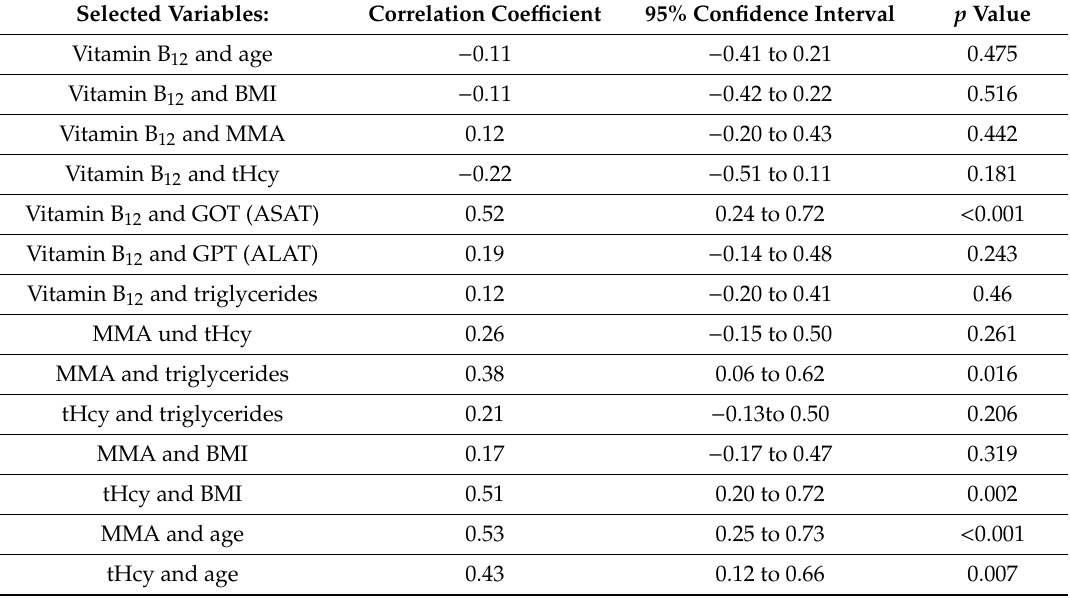
Table 3. Correlation analyses in healthy controls. Correlations were tested using the Spearman’s rank correlation coe ffi cient. The significance level was set to α =